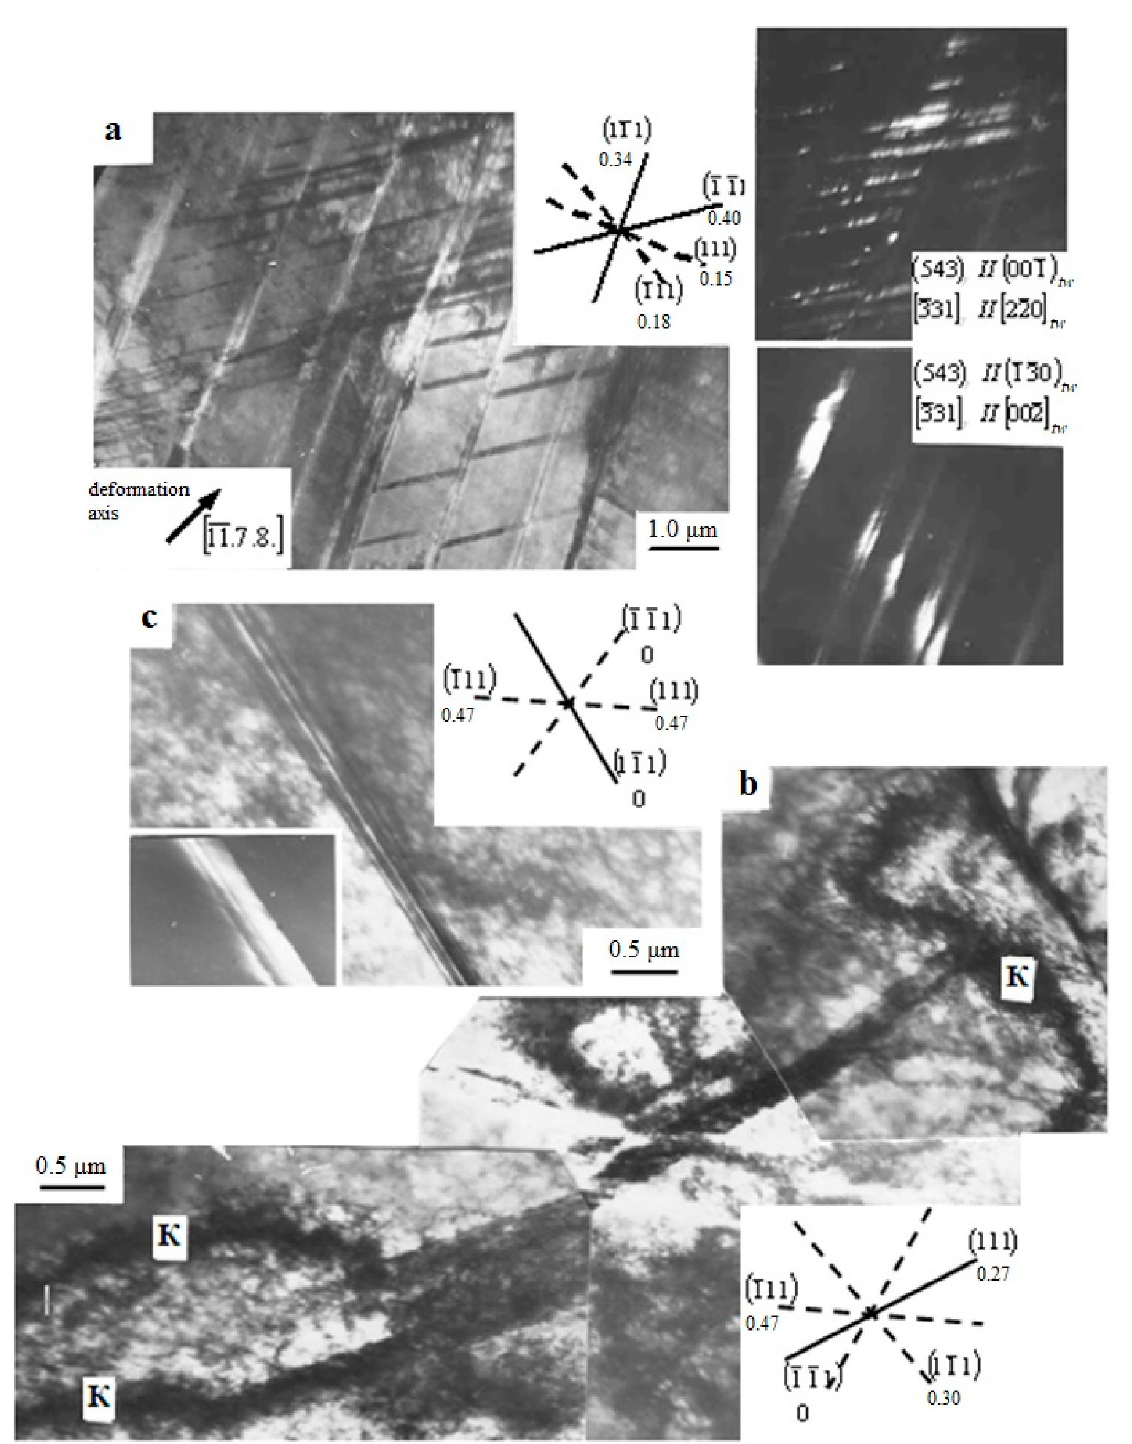
Figure 12. TEM micrographs of the microstructure of Hadfield steel deformed with ε = 25%: ( a ) samples after tension; ( b , c ) cold-rolled samples with an indication of the values of the Schmid factors, operating (solid line) and non-operating (dotted line) twinning systems, as well as extinction contour K.